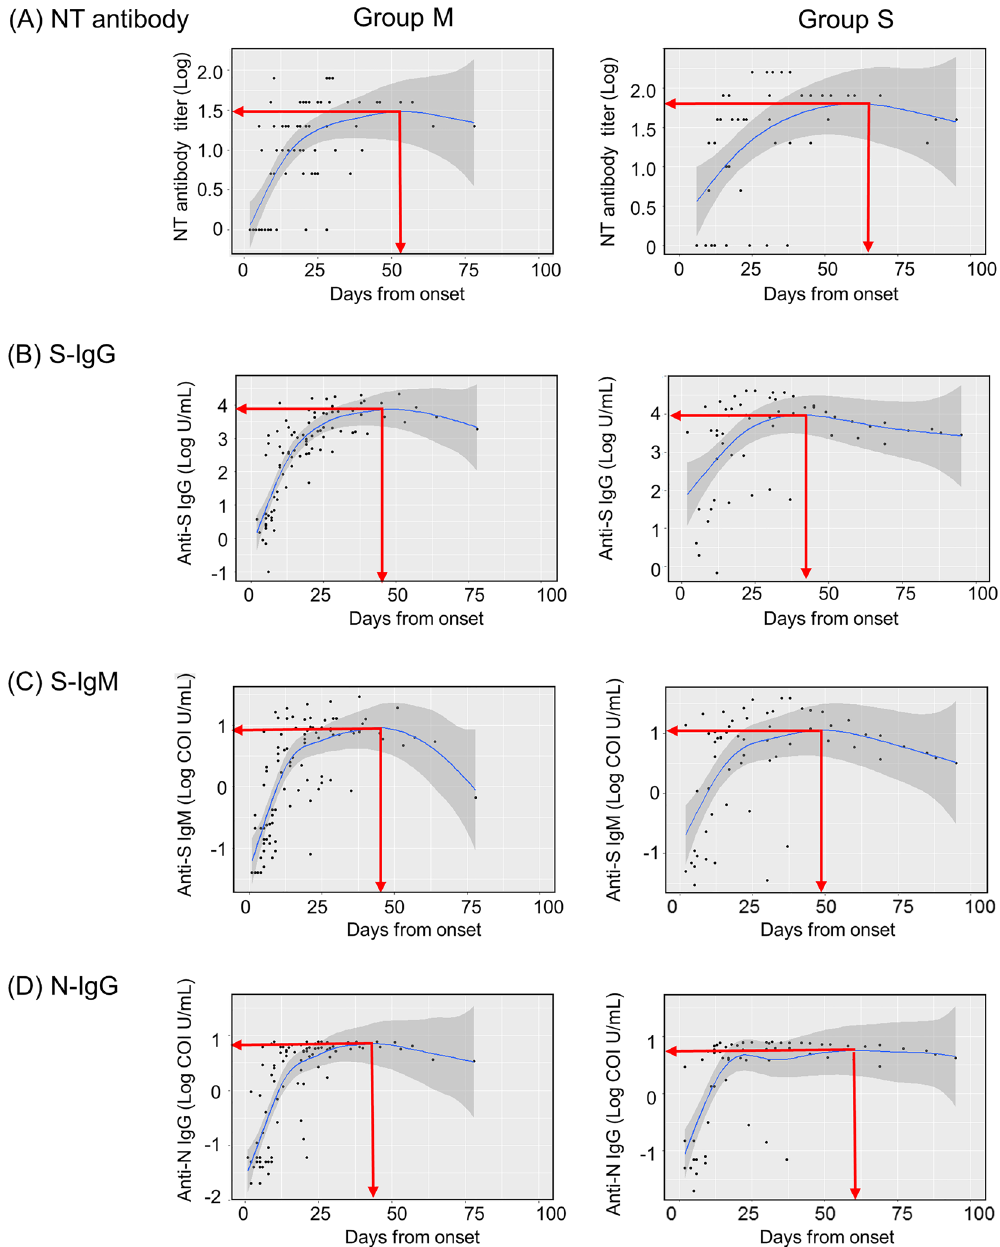
Figure 2. Longitudinal change of antibodies against SARS-CoV-2. Scatterplot and regression lines indicate antibody response for longitudinal analysis: Group M (n = 95 from 52 patients) and Group S (n = 73 from 16 patients). ( A ) NT antibody, ( B ) S-IgG, ( C ) S-IgM, and ( D ) N-IgG. The 95% CIs are calculated by prediction ± 1.96 × standard error of prediction. The red lines indicate the points in which the fitted curves are at their maximum. These points are as follows: ( A ) NT antibody; Group M, day 53, log titer 1.48; Group S, day 69, 1.79, ( B ) S-IgG; Group M, day 46, 3.87; Group S, day 45, 3.96, ( C ) S-IgM; Group M, day 45, 0.96; Group S, day 49, 1.06, ( D ) N-IgG, Group M, day 46, 0.90, Group S, day 60,